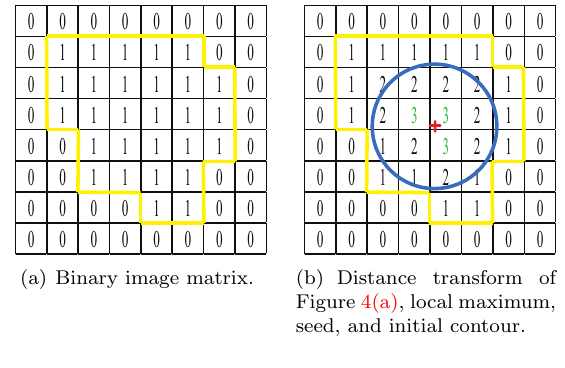
Figure 4: Contour initialization